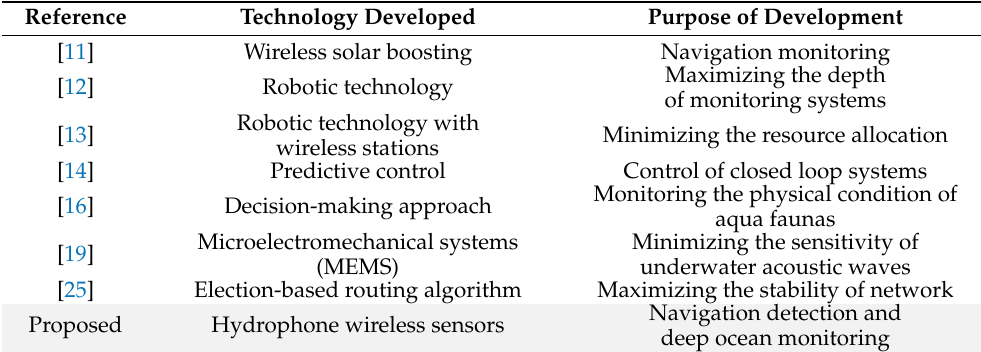
Table 1. Key methodology in conventional